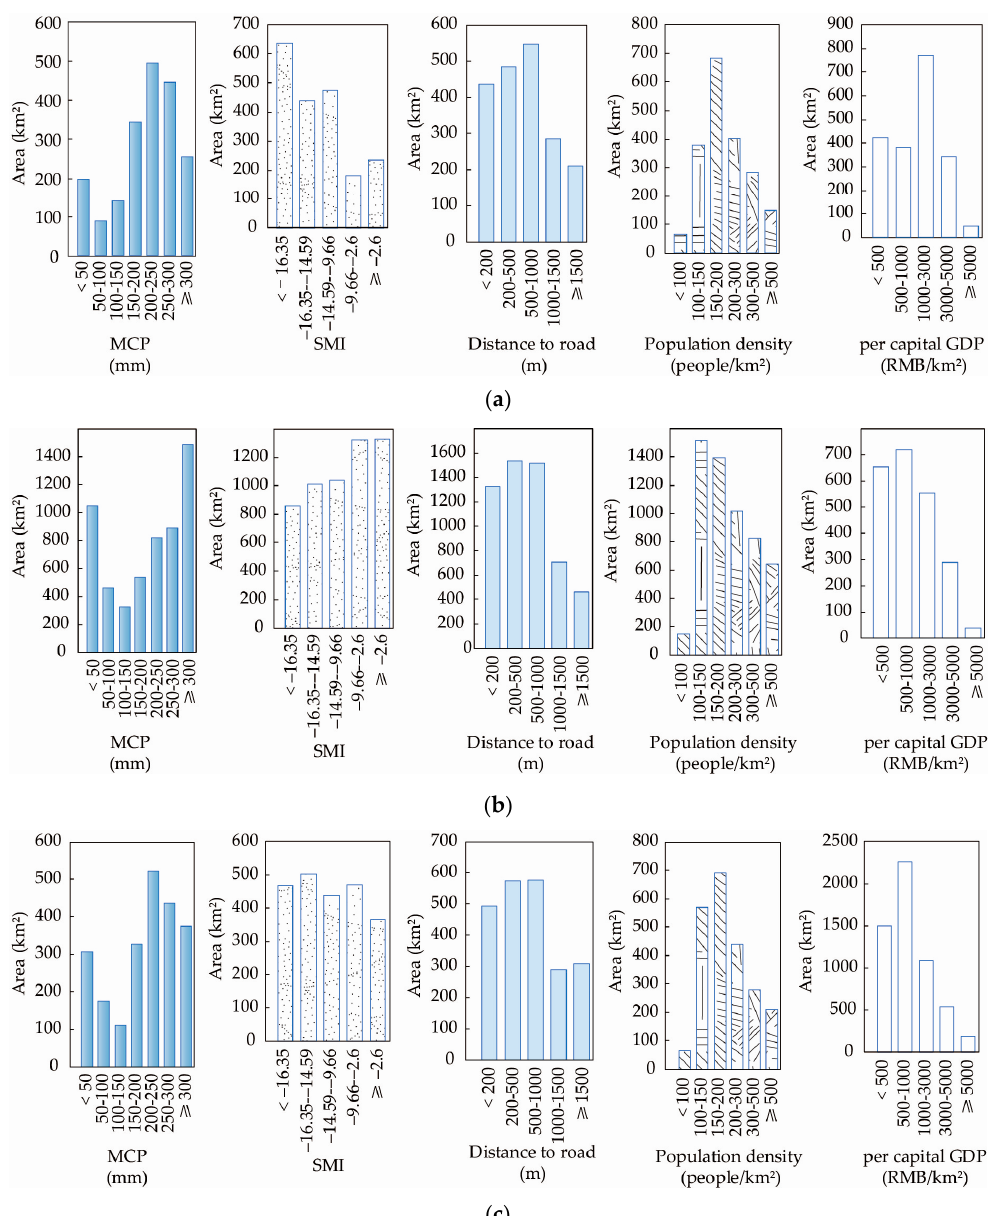
Figure 11. Relationship between the influencing factors and catchment area of different DFP types.